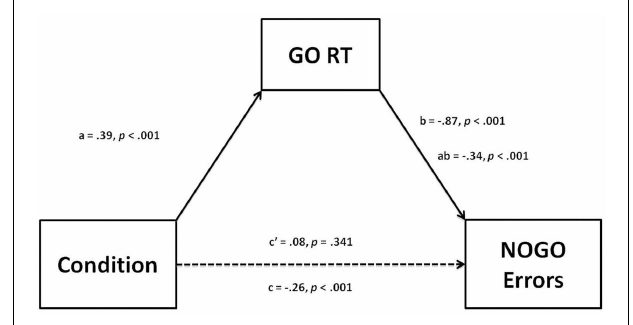
FIGURE 1 | Mediation model for Condition (Standard versus Go-Slow Instructions) with GO RT as a mediator of NOGO Errors . a = direct effect of Condition on GO RT, b = direct effect of GO RT on NOGO errors, ab = indirect effect of Condition via GO RT on NOGO errors. c (cid:48) = direct effect of Condition on NOGO errors, c = total effect of Condition on NOGO